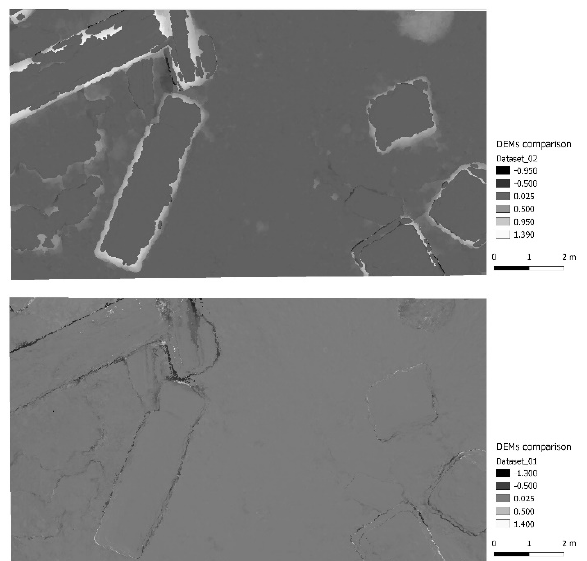
Figure 8. Examples of DEMs comparison. In this case two different datasets have been compared with a reference one.